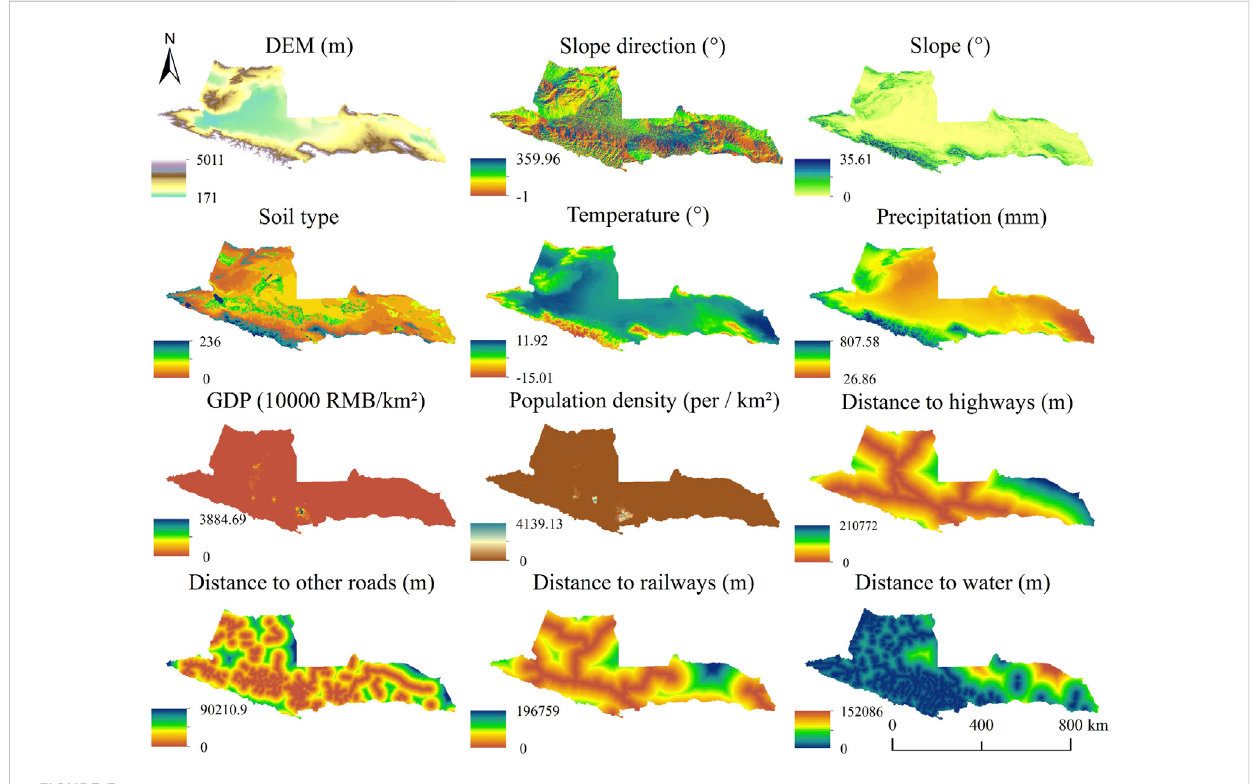
FIGURE 3 Driving factors affecting land